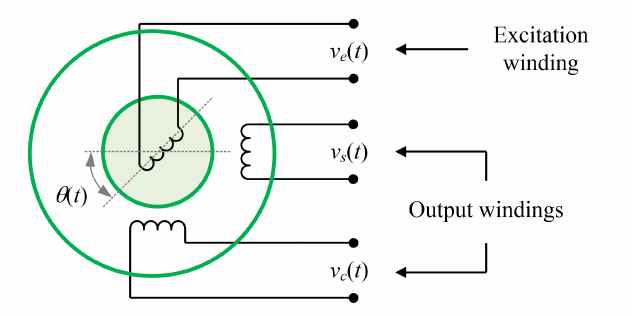
Figure 1. Schematic diagram of the resolver